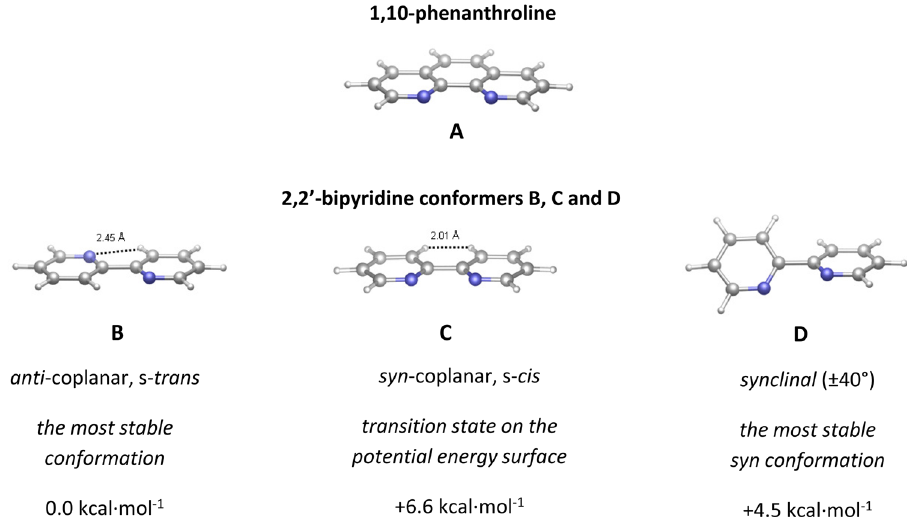
Fig. 3 Comparison of the structure of 1,10-phenanthroline and relevant conformers of 2,2 ′ -bipyridine. The optimized structures of 1,10-phenanthroline ( A ) and the relevant 2,2'-bipyridine conformers ( B , C , D ). The corresponding relative Gibbs free energies have been obtained from DFT calculations performed at the ω B97XD/Def2TZVPP// ω B97XD/Def2SVP//